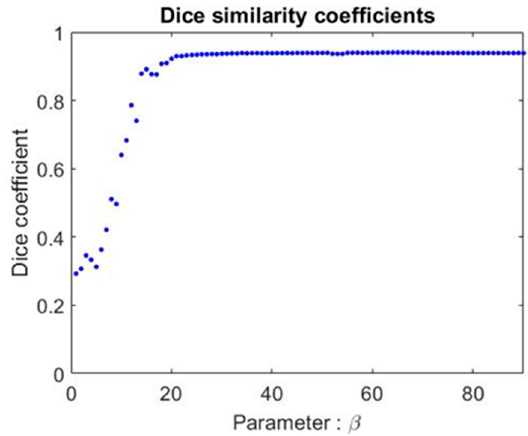
Figure 6. The Dice coefficient using different β values under the contouring of the lung. The two sets for comparison of the similarities are our automated contouring and the expert’s manual delineations.